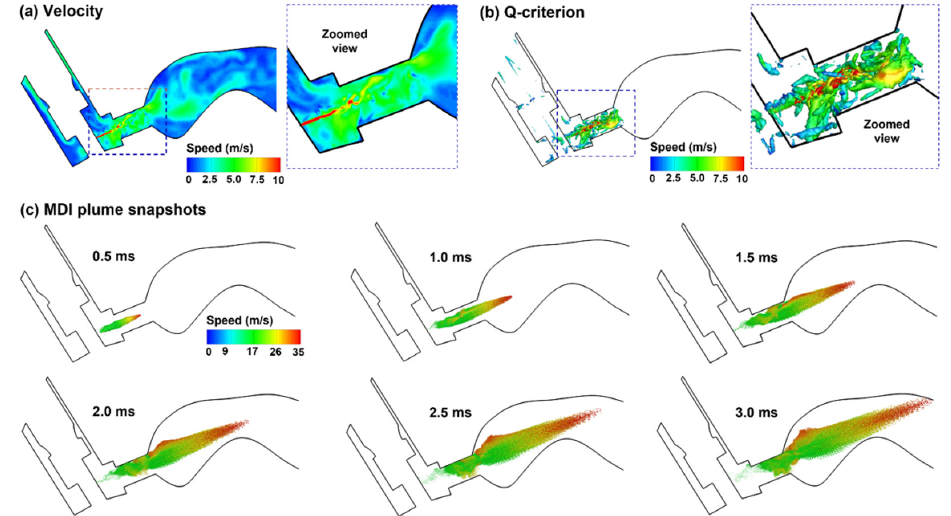
Figure 5. Airflow and droplet dynamics during MDI actuation (0.5–3.0 ms): ( a ) mid-plane velocity contour showing the jet flow from the nozzle and the heterogeneous flow distribution in the oral cavity, ( b ) jet-induced vortex structures in the mouthpiece of the MDI, and ( c ) snapshots of the MDI plume at varying instants (0.5–3.0 ms) after actuation. Flow and droplets were colored by their perspective velocities.